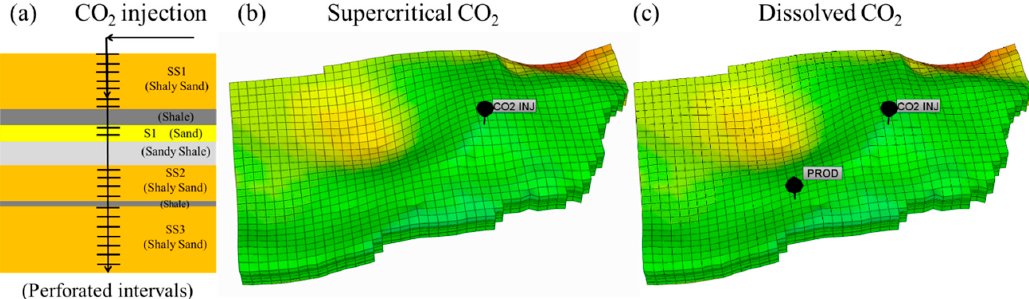
Figure 4. The injection scenario used in this study ( a ) Schematic diagram of the injection interval in the YTP formation; ( b ) schematic diagram of the supercritical CO 2 scenario; ( c ) schematic diagram of the dissolved CO 2 solution scenario.